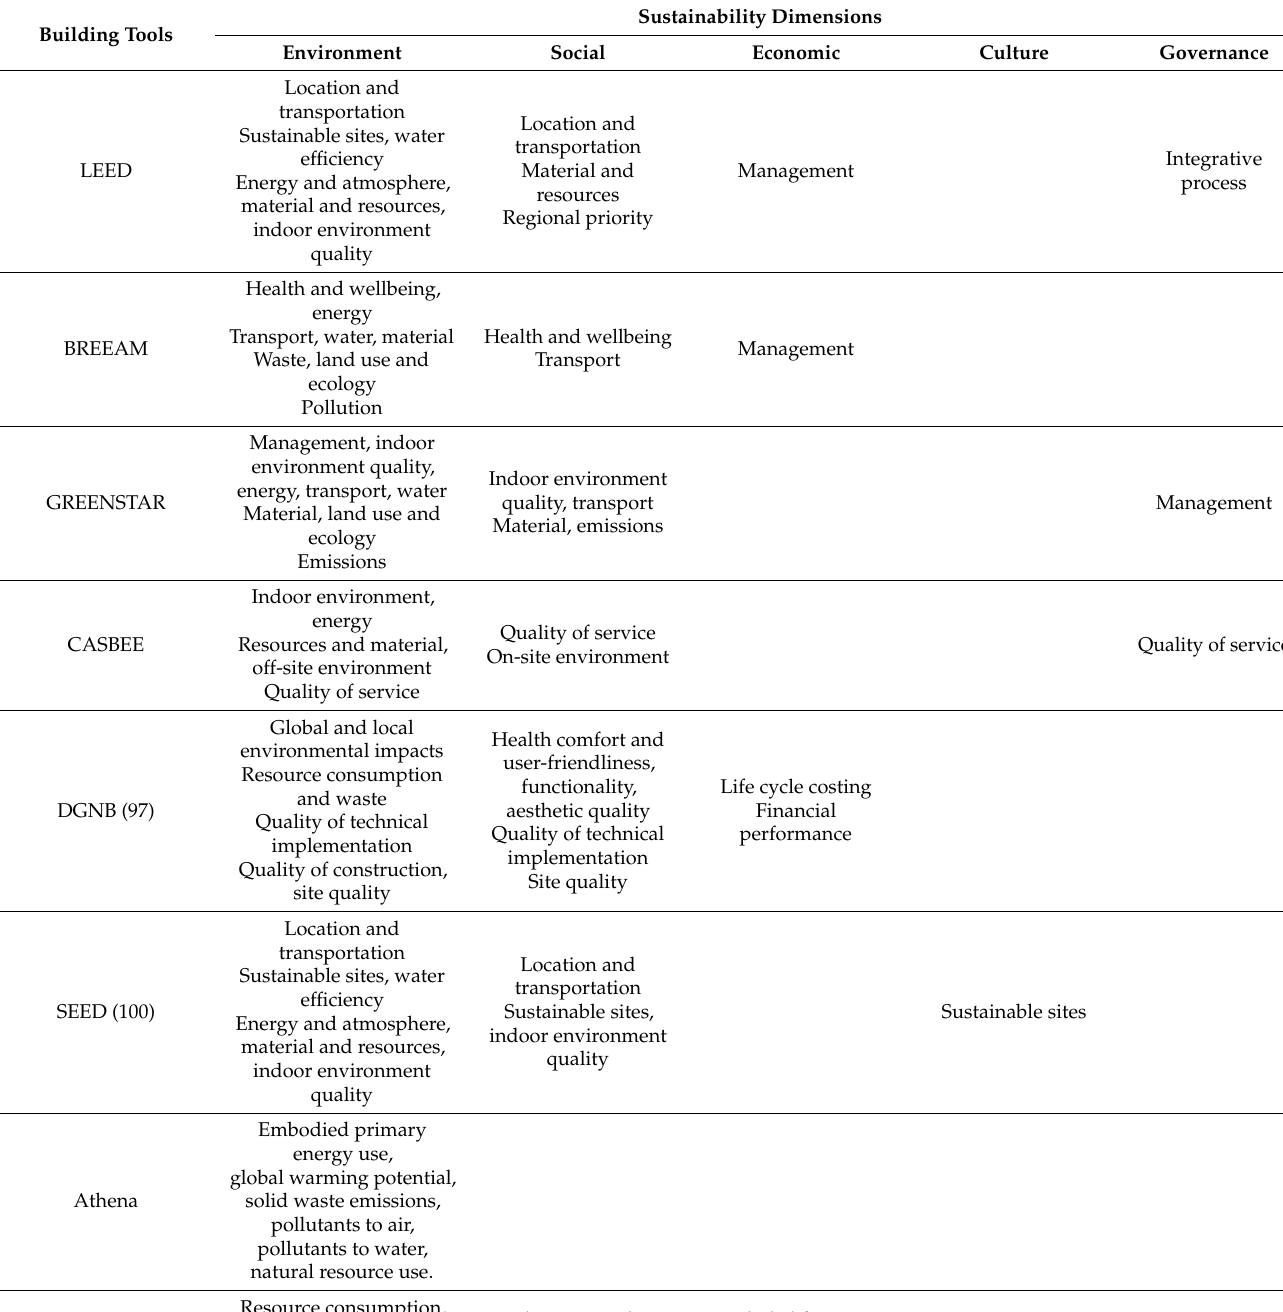
Table 4. Division of indicators in all the five dimensions within eight building rating